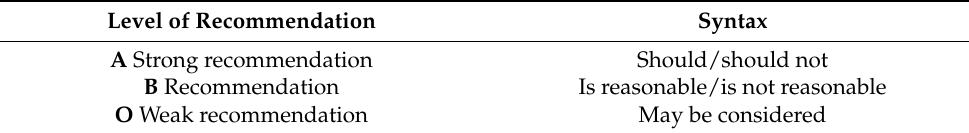
Table 3. Levels of recommendation.